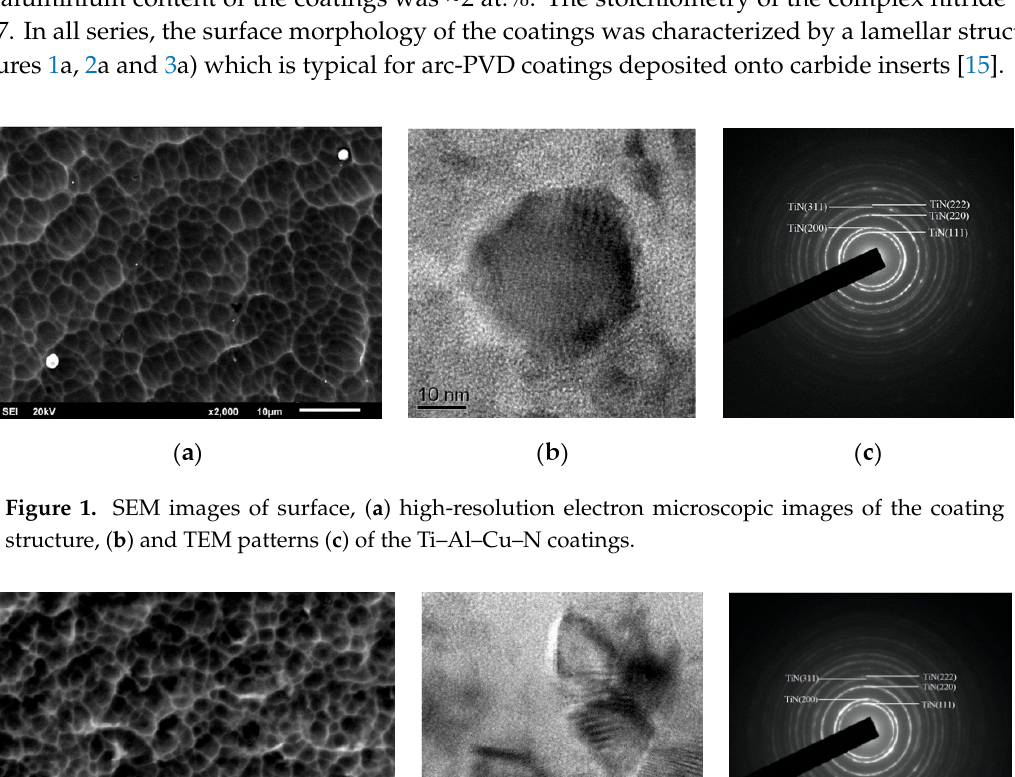
Figure 3. SEM images of surface, ( a ) high-resolution electron microscopic images of the coating structure, ( b ) and TEM patterns ( c ) of the Ti–Al–N coatings.